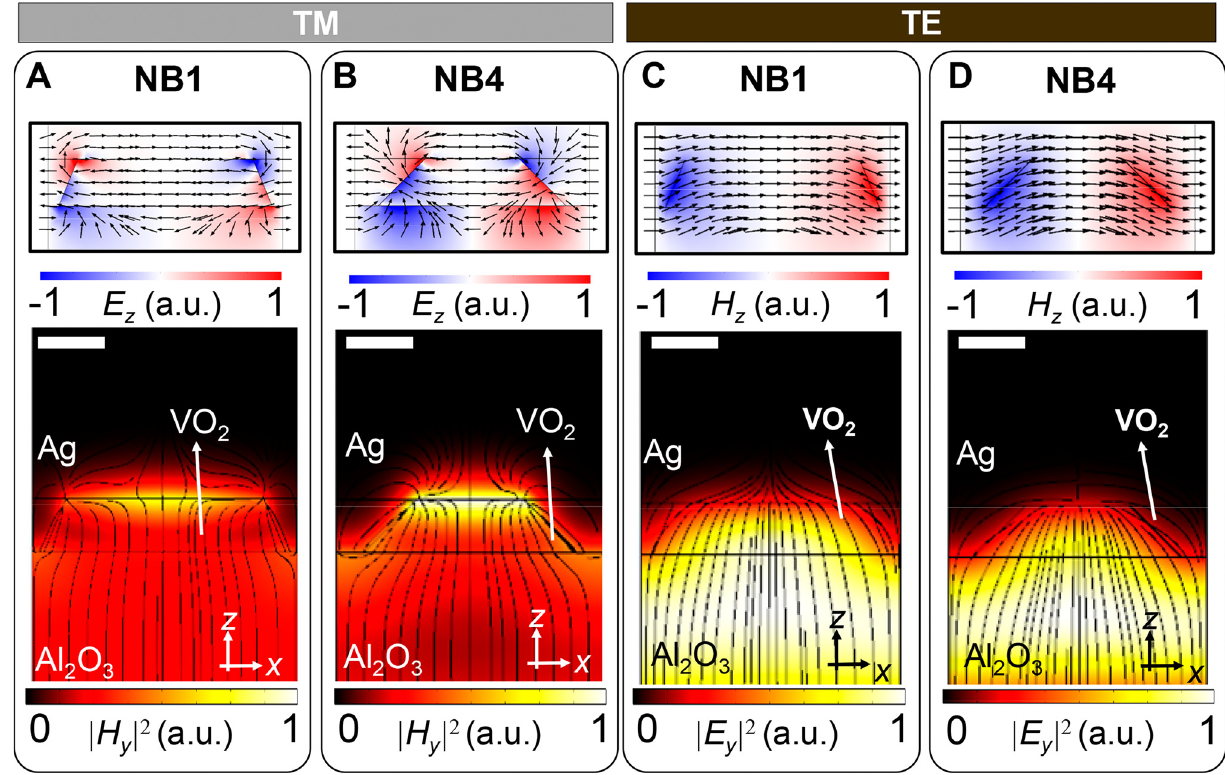
Figure 3: Nanoscopic mechanisms of the resonant near-unity absorptions: subwavelength light funneling into the metafilms. Electromagneticfieldprofilesof(A,C)NB1and(B,D)NB4devicesarenumericallyinvestigatedattheresonancesintheinsulatingphasefor(A, B) TM and (C, D) TE illumination, respectively. Upper figures show the (A, B) E z and (C, D) H z , with the normalized black vector arrows of (a, b) displacementcurrentand(c,d)magnetic fi eld,respectively.Lower fi guresshownormalizedelectromagnetic fi eldpro fi lesof(A,B) | H y | 2 and(C, D) | E y | 2 . Black lines in the lower fi gures depict the fl ow of Poynting vectors coming from the free space of Al 2 O 3 substrate to the PCMA structures. The scale bars correspond to 60